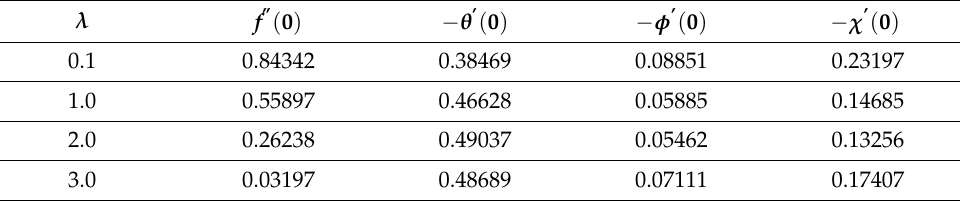
Table 1. Physical behavior of ( a ) f (cid:48)(cid:48) ( 0 ) ( b ) − θ (cid:48) ( 0 ) ( c ) − φ (cid:48) ( 0 ) ( d ) − χ (cid:48) ( 0 ) at angle π /6